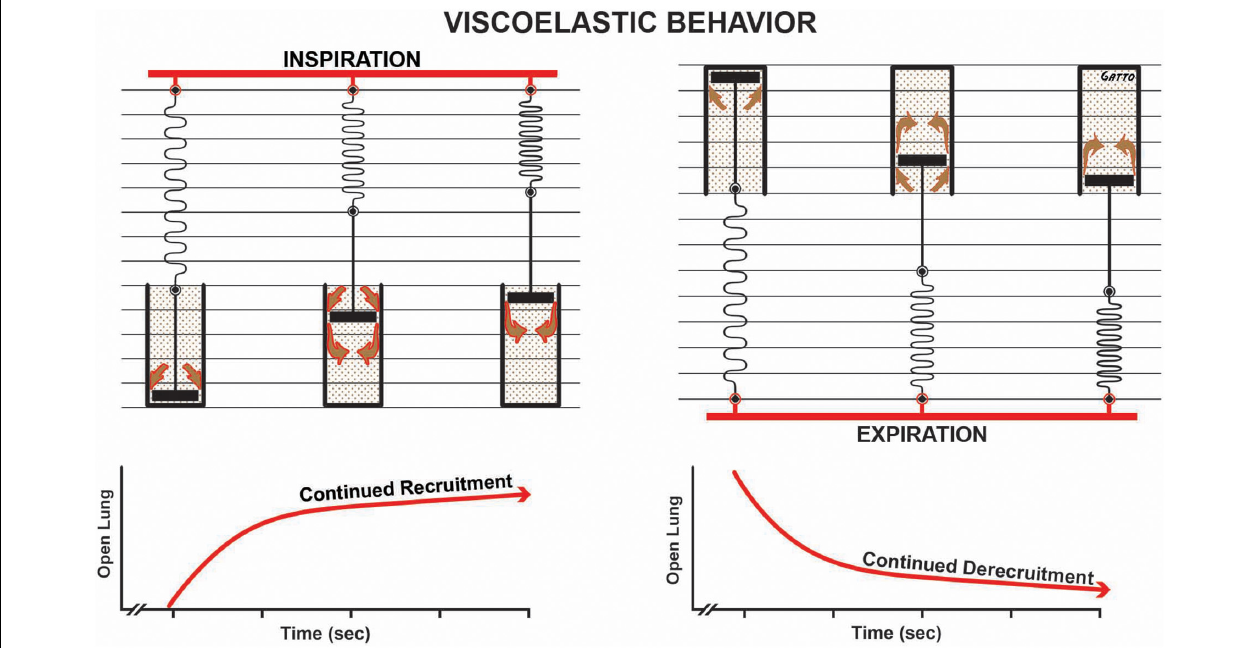
FIGURE 9 | Viscoelastic behavior of alveolar recruitment and derecruitment described using a spring and dashpot model. During inspiration the spring is rapidly stretched, whereas the dash in the pot moves more slowly as fluid squeezes around it (brown arrows), in response to the applied force (i.e., tidal volume – red bar). The effect of this viscoelastic behavior is continual alveolar recruitment as long as inspiration is held (open lung/time curve). Viscoelastic behavior during expiration shows a rapid collapse of the spring and a much slower collapse of the dash in the pot. This is shown in the open lung/time curve as continuous alveolar collapse or derecruitment over time. Viscoelastic alveolar opening and collapse suggests that the longer inspiration is held, the more alveoli are recruited, and the shorter the expiratory time, the fewer the alveoli that